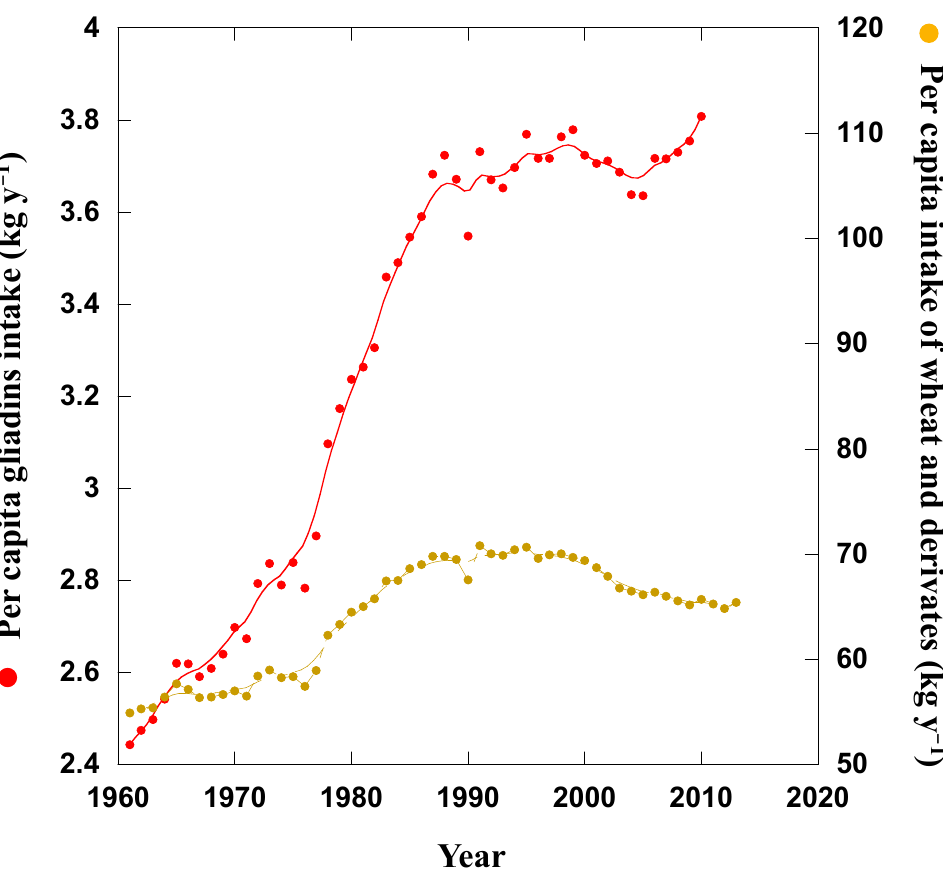
Figure 4. Per capita gliadin intake (g y − 1 ) and per capita wheat and derivates intake (kg y − 1 ).